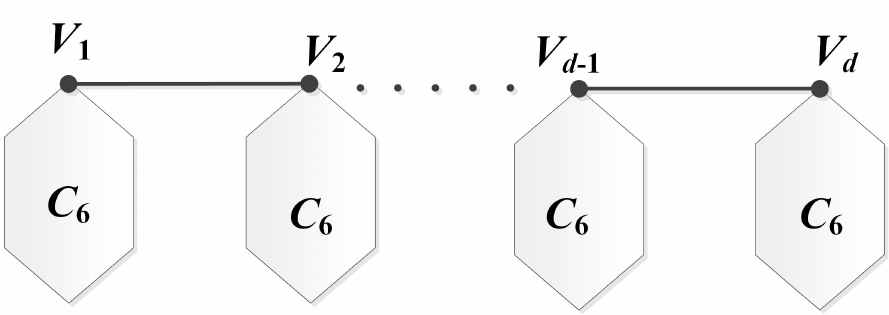
Fig. 6 The nano structures bridge graph G d ( C 6 , v